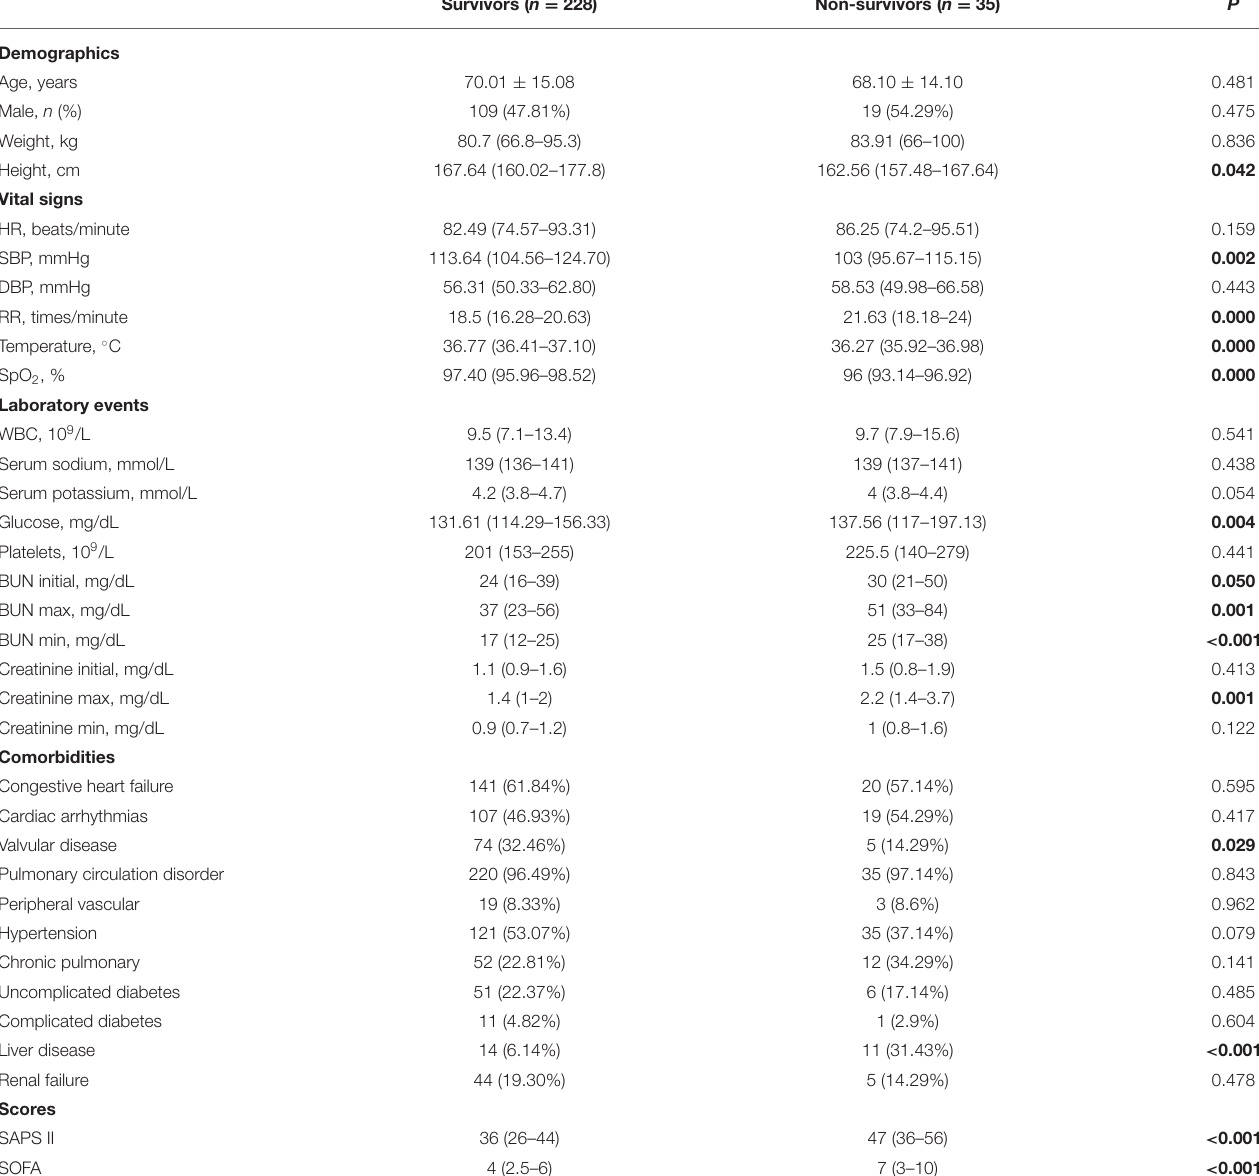
TABLE 1 | Baseline characteristics of the study population with different survival status in